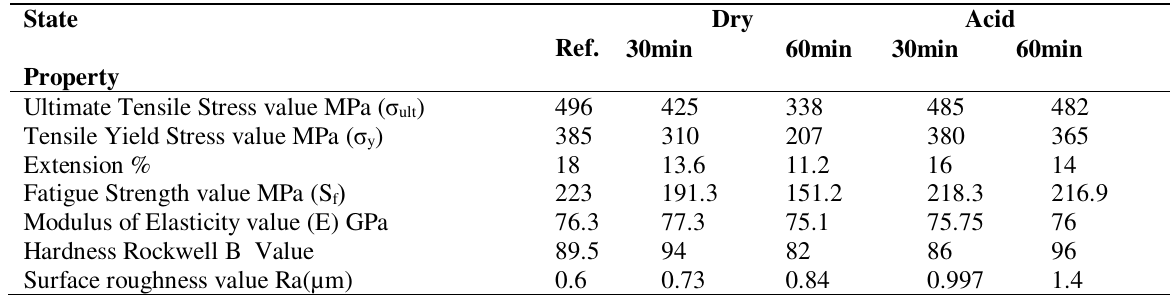
Mechanical Properties of AA 7075-T73 have been calculated of the four groups.